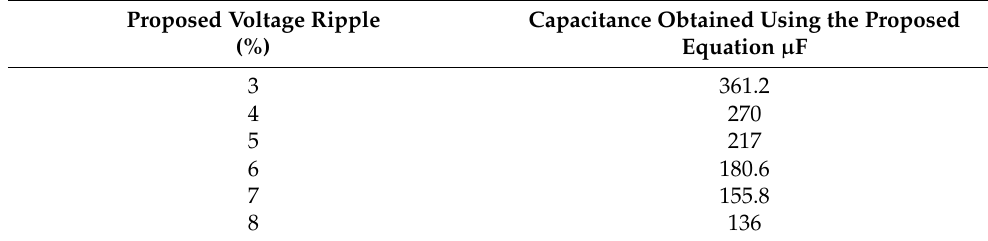
Table 6. Proposed voltage ripples and obtained minimum capacitance. Proposed Voltage Ripple